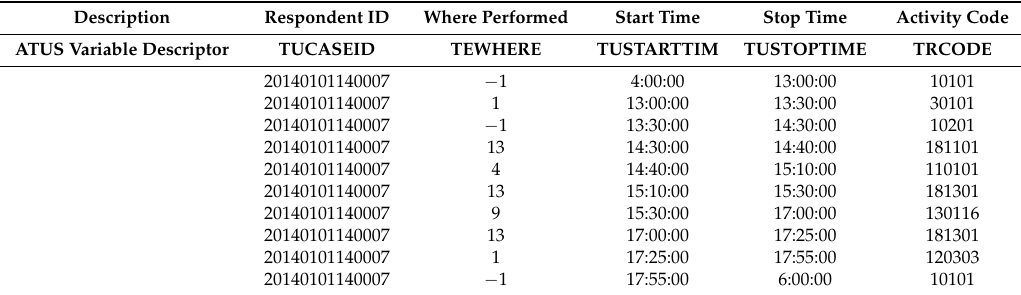
Table 1. Sample time diary data from the American Time Use Survey